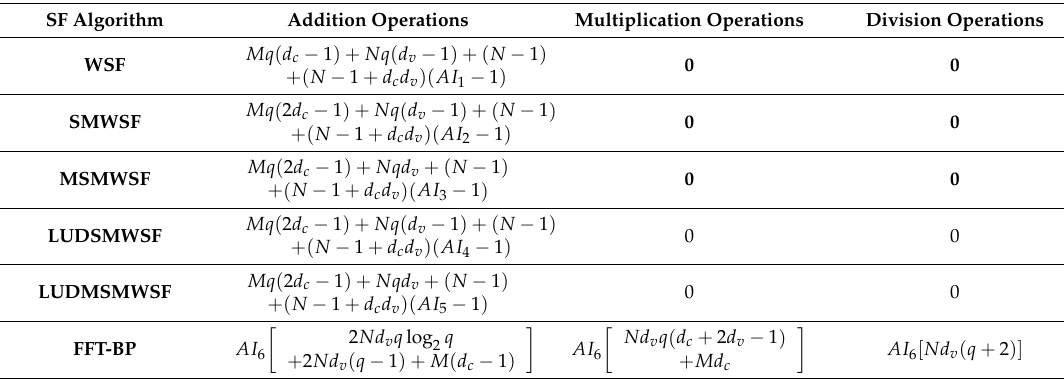
Table 1. The average total number of real operations in each